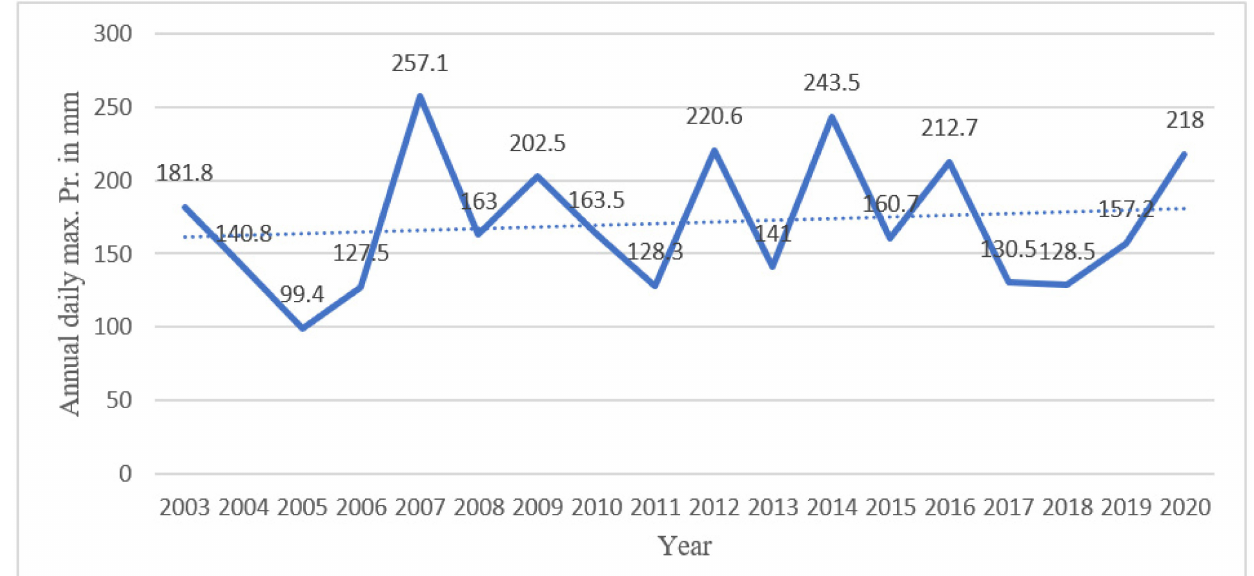
Figure A11. Observed annual daily maximum precipitation of Tatopani, Myadi.